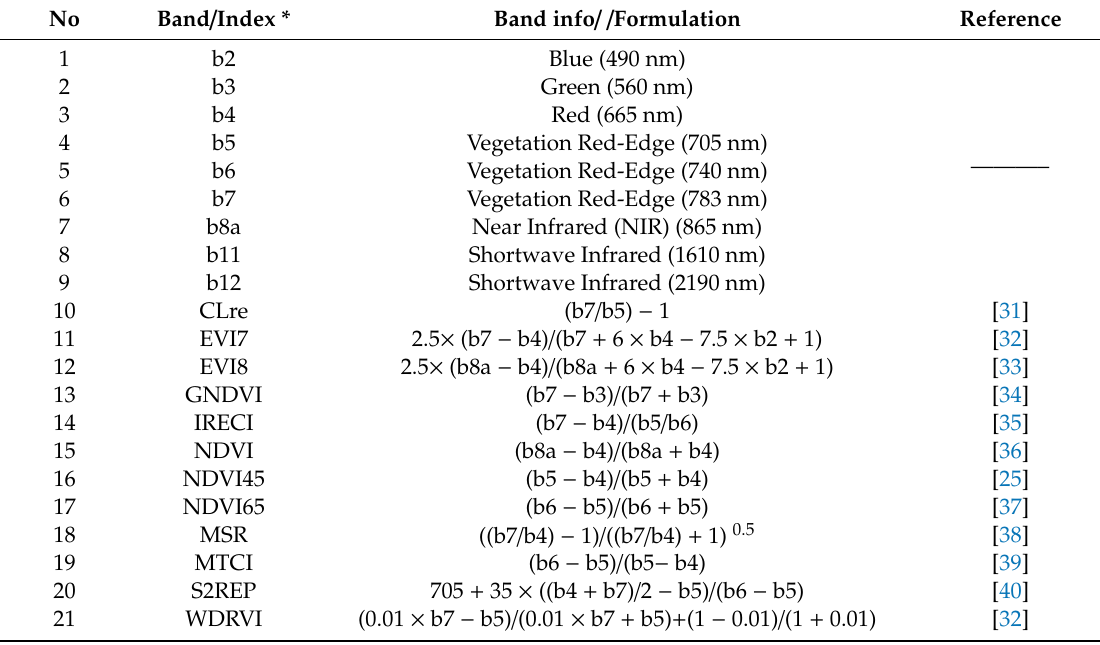
Table 1. Sentinel-2 variables used in the study (all at 20 m spatial